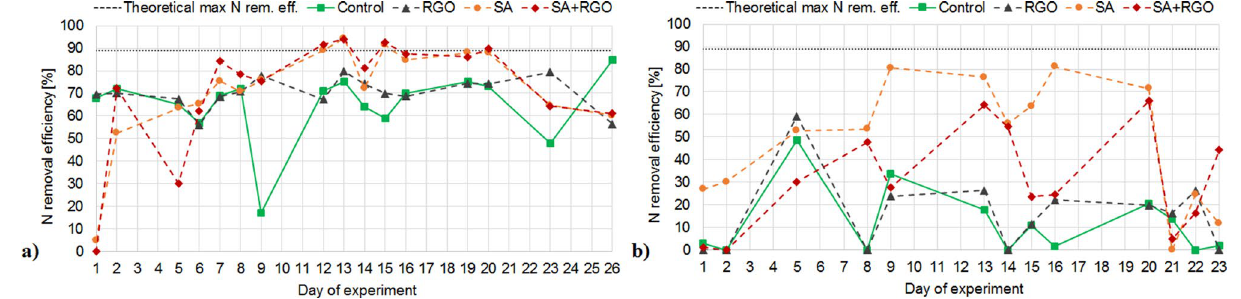
Figure 3. Nitrogen removal efficiency in SBRs operated at ( a ) 23 °C and ( b ) 15